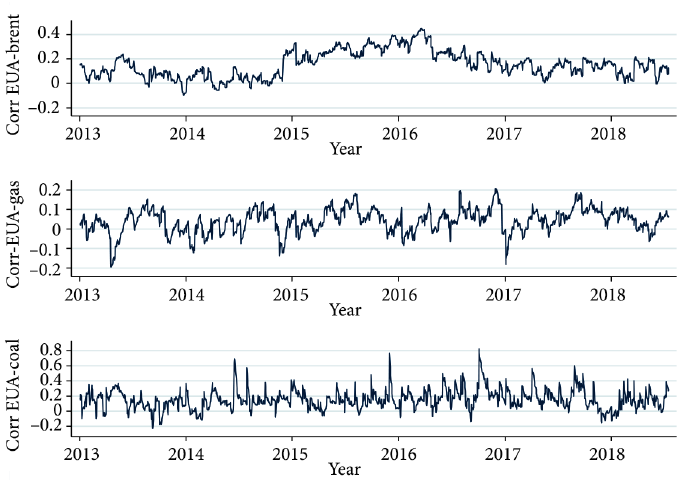
Figure 7. Dynamic correlation between the daily log returns of EUA and the energy futures from the phase III of EU